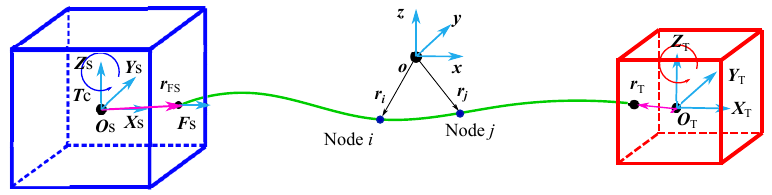
Figure 8. Concept of the ANCF model for a single tether